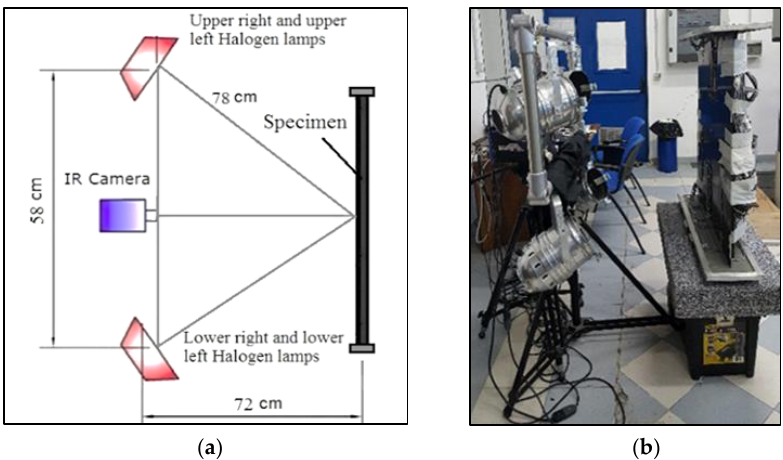
Figure 5. ( a ) Lateral view of the thermographic setup for multi-stringer component’s acquisition and ( b ) experimental setup. Table 5. Scheduling tests for the multi-stringer component’s investigation